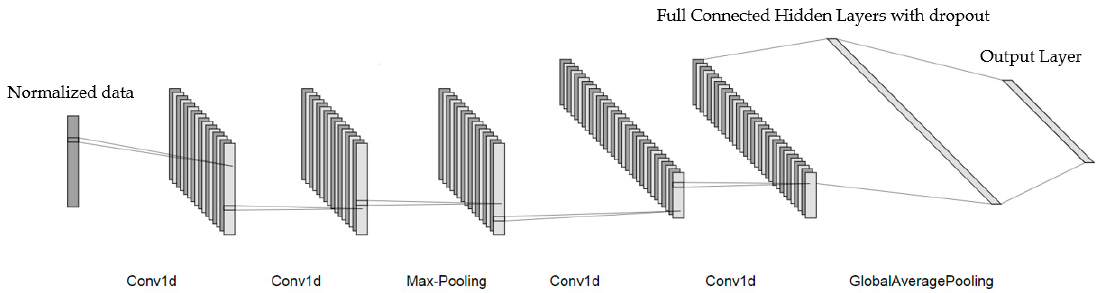
Figure 7. 1D-CNN network architecture applied in this study.